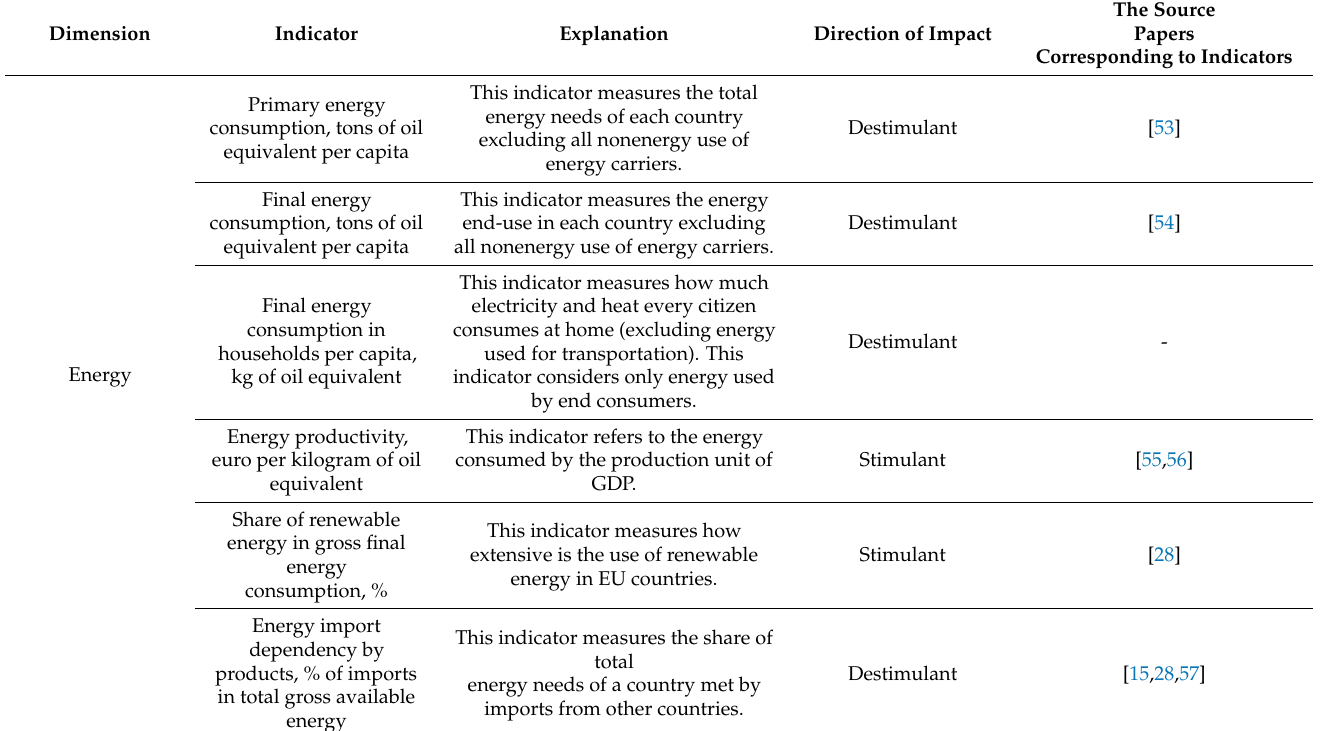
Table 1. Variables, units, and the explanation of statistical data (own elaboration based on [27]). Dimension Indicator Explanation Direction of Impact